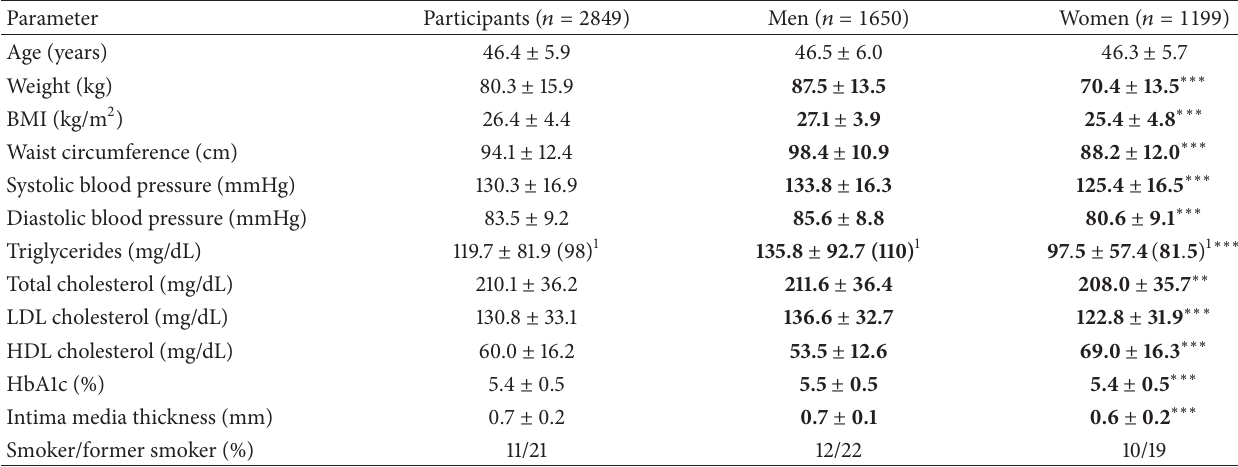
Table 1: Baseline characteristics.